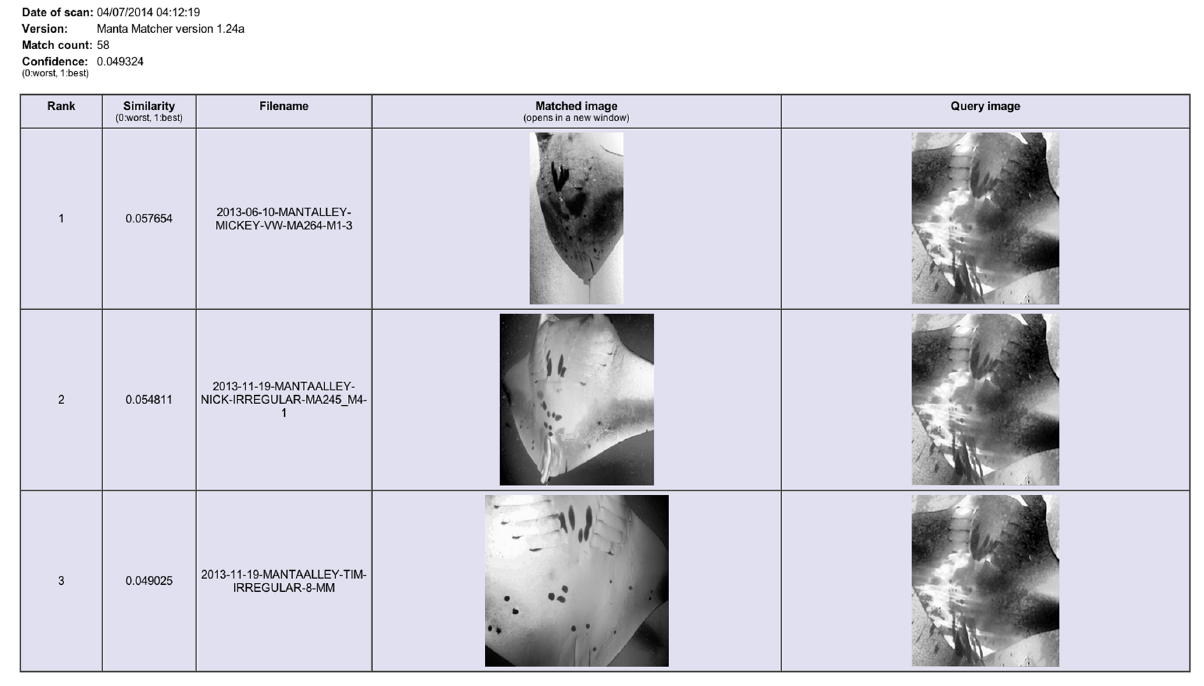
Figure 6. The ‘Manta Matcher’ matching algorithm screen grabs for INNLP0229A showing the top three matched images. Ranked hit 1 (re-sighting in WM & K) is a true match for the query image of ray INNLP0229A (initial sighting in NP).